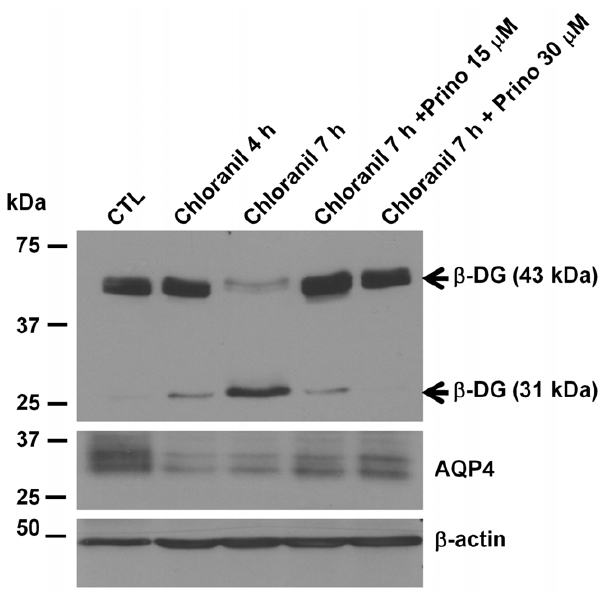
Figure 6. Time-dependent shedding of ß-dystroglycan by chloranil is blocked by the metalloproteinase inhibitor, prinomastat. Primary astrocytes were incubated with 25 m M chloranil for 4 or 7 h with or without addition of 15 nM or 30 nM prinomastat. Extracted proteins were loaded (30 m g/lane) and analyzed for ß-DG and AQP4 expression levels by western blot analysis. Note the increase in signal intensity of the 31 kDaß-DG band after extended incubation with chloranil and its disappearance with prinomastat co-incubation.